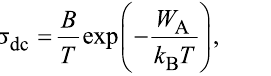
be considered when interpreting experimental data, namely the electrode polarization, resulting from charge accumulation at the electrode/sample